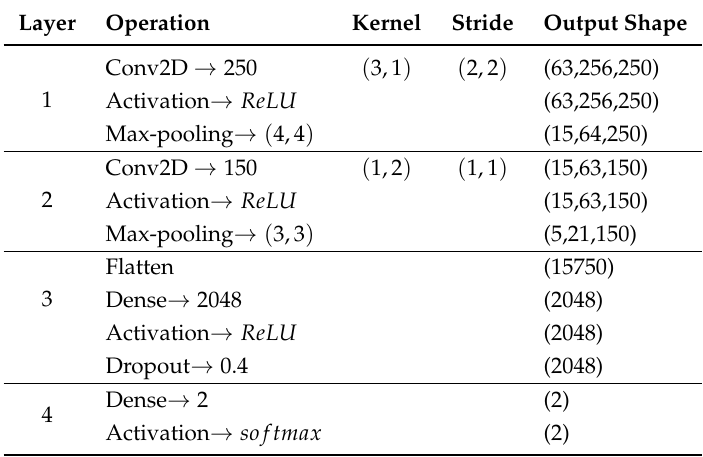
Table 1. CNN modified architecture inspired from